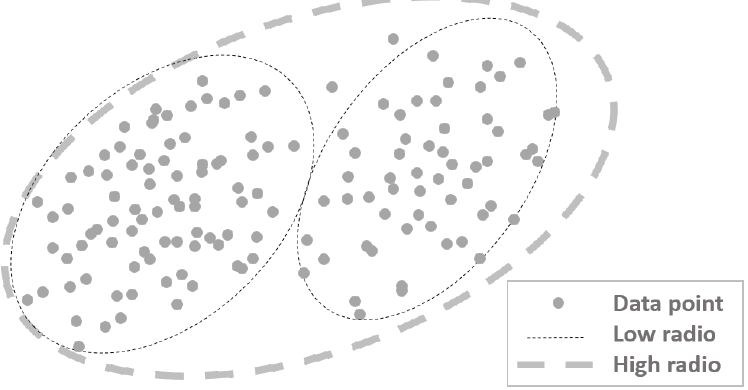
Figure 8. Radius of influence in the subtractive clustering